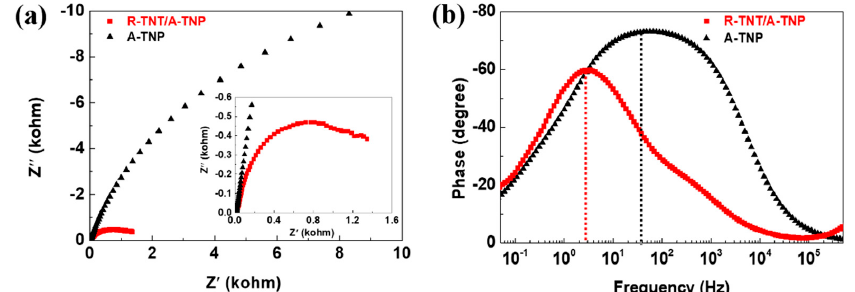
Figure 6. Electrochemical impedance spectroscopy of R-TNT/A-TNP and A-TNP: ( a ) Nyquist plots of photoanodes collected at 0.7 V RHE in 1M KOH (pH~14) electrolyte under 1 sun illumination. Inset is a zoomed-in spectra at high frequencies. ( b ) Corresponding Bode plots of photoanodes.